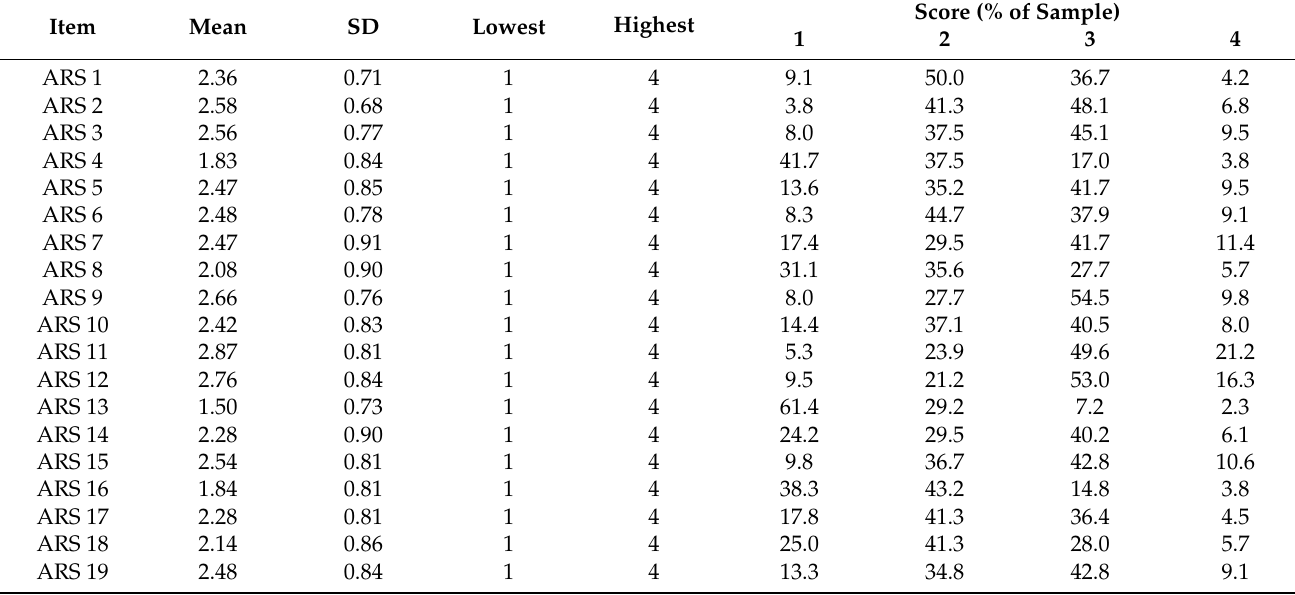
Table A2. Descriptive statistics of the Anger Rumination Scale (ARS)